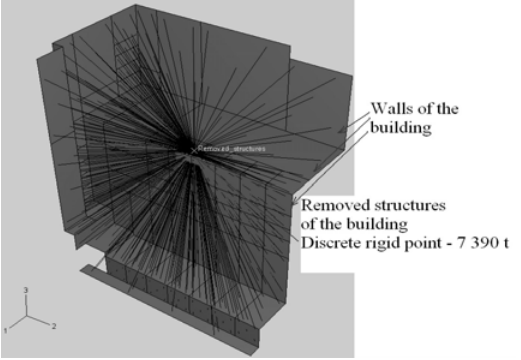
Fig. 4. Illustration of distribution of mass of the removed structures of building to the